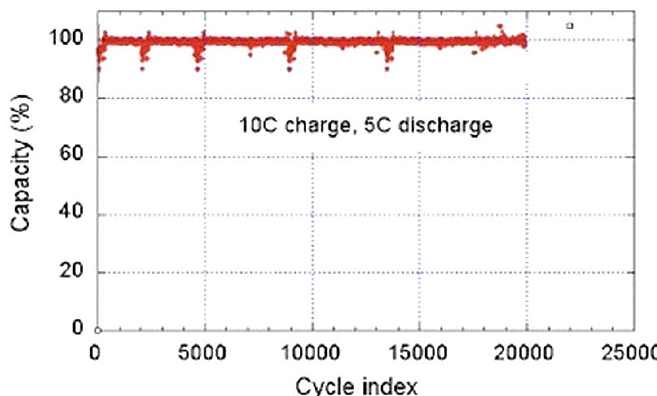
Figure 11. Cycle life of a LiFePO charge rate is 10C (6 min) at 100% state of charge, the discharge rate is 5C (12 min) at 100% depth of discharge during the test (Reprinted with permission from [68]. Copyright 2011 Elsevier).